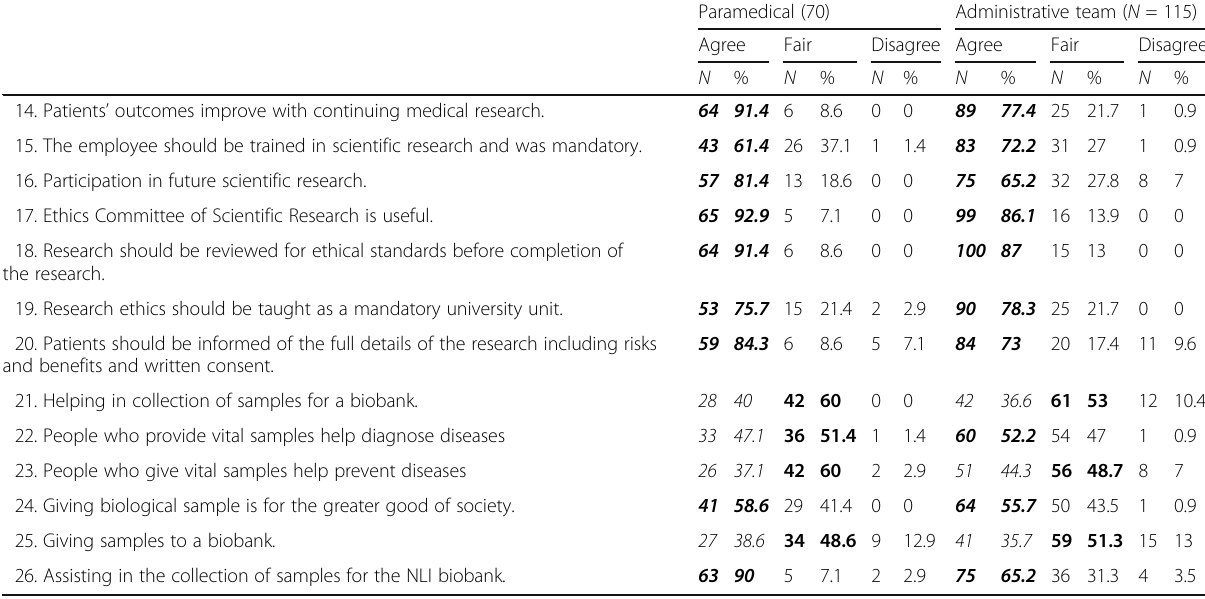
Table 3 Research, research ethics, and biobank attitude of the studied paramedical and administrative team participants, pre-